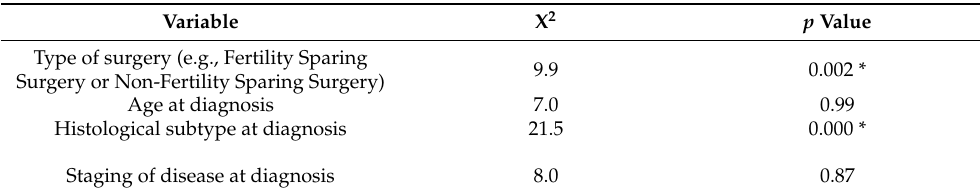
Table 6. Comparison amongst women with non-invasive recurrences and malignant